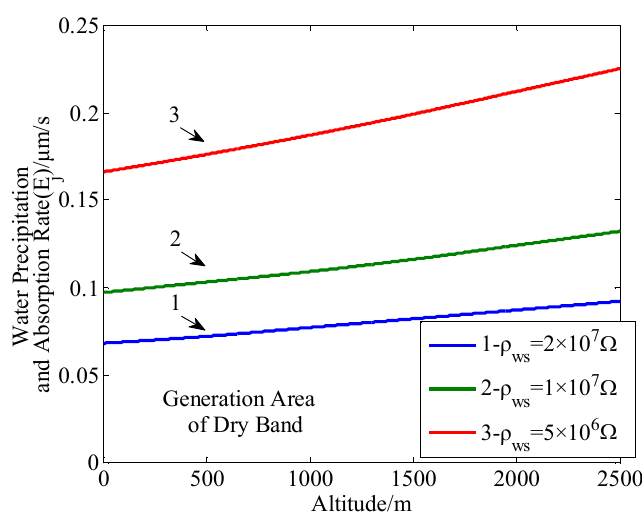
Figure 8. Influence of altitude on dry band formation.